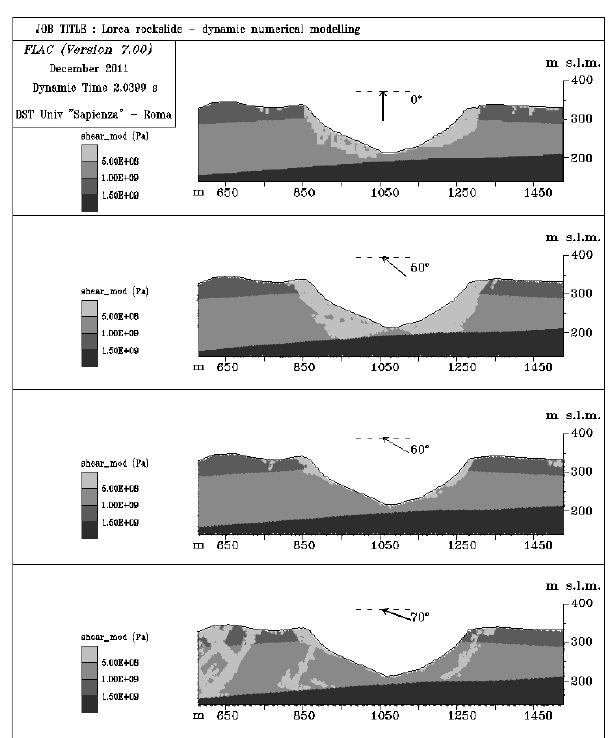
Fig. 9. Contour plot of the shear modulus values calculated from the FLAC dynamic numerical modeling using seismic wave propa- gation at various incidence angles.